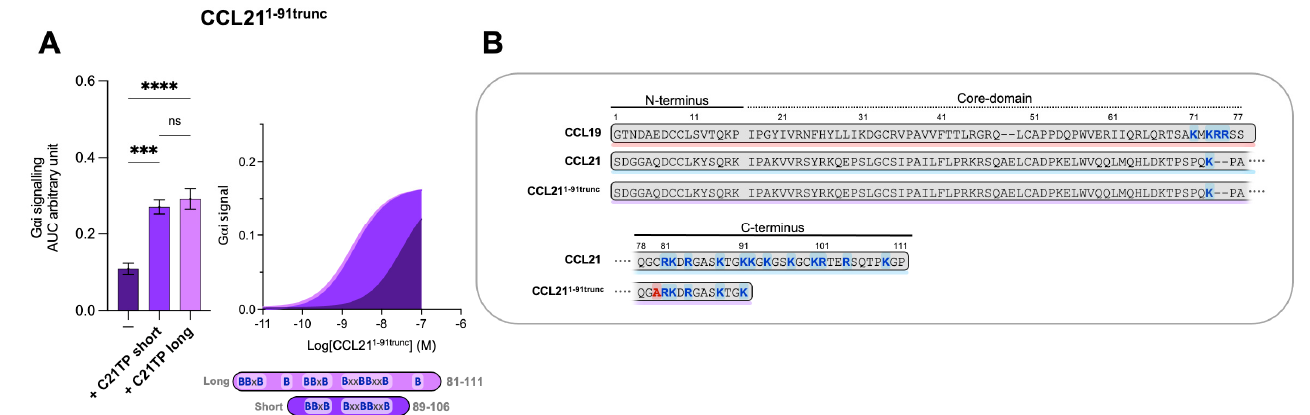
Figure 4. Long and short C21TP variants boost CCL21 1 − 91trunc activity in G α i signaling equally. Areas under the curve (AUCs, arbitrary units) of cAMP signaling are shown as bar graphs and AUC curves. The length and location of BBx(x)B motifs in the short and long C21TPs are shown as graphical bars. ( A ) The effect of short (89–106) and long (81–111) C21TPs on G α i signaling in response to CCL21 1 − 91trunc was measured using BRET-based assays. C21TPs were added to a final concentration of 10 µ M. Statistical significances were determined using one-way ANOVA with Tukey’s multiple comparisons test ( n = 3). *** p < 0.001, **** p < 0.0001, ns non significant. ( B ) Alignments of chemokine sequences; CCL19, CCL21, and CCL21 1 − 91trunc . Basic residues in the C-terminal region of the chemokines are written in bold and marked with blue. The alanine substitution (C80A) is written in bold and marked with red.